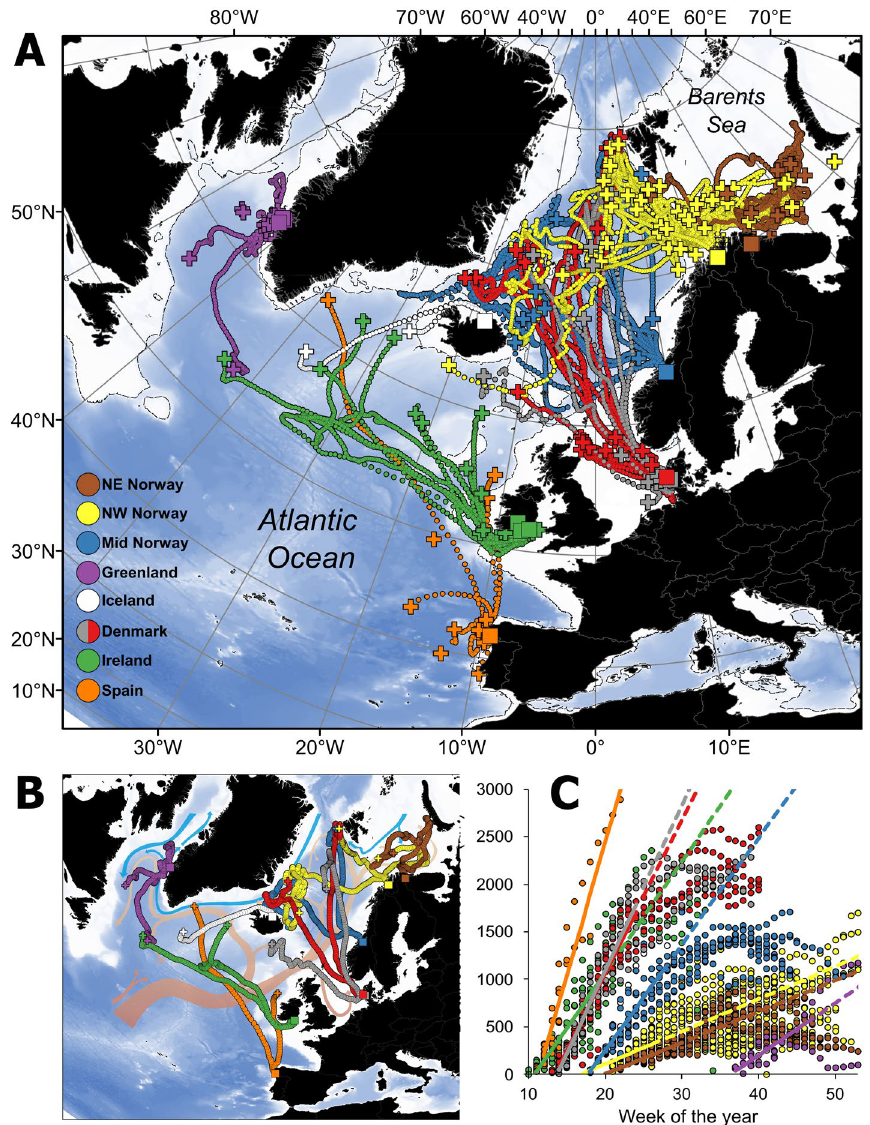
Figure 1. Migrations of Atlantic salmon tagged in eight different geographic areas. Release locations post- tagging are shown by squares (from 11 northeast Atlantic river catchments and at-sea at Western Greenland). ( A ) Estimated daily geographic location of 105 salmon (circles) from the release location. Crosses show the pop-up location of the tags of these salmon, as well as those for an additional 43 salmon for which detailed movement reconstructions were not possible. The dashed line shows the 500 m depth contour, while darker blue shading indicates increasing depth as per the GEBCO bathymetry 44 . ( B ) Example migrations of individual fish from each catchment and arrows showing main ocean current systems of warm (light brown arrows) and cold (blue arrows) water in the North Atlantic Ocean. ( C ) The weekly mean distance from the release location for salmon from each tagging group (circles, estimated as distance along a straight line from the release location). Fitted lines show the regression (significant for all groups) between week of the year and distance for the first 11 weeks after release only, corresponding to the time required to reach principal feeding areas for most populations (regression lines were extended as dashed lines past the first 11 weeks for display purposes only). Iceland was not included in ( C ) due to our small sample size of fish from this area. Maps were drawn using ESRI ArcGIS Desktop